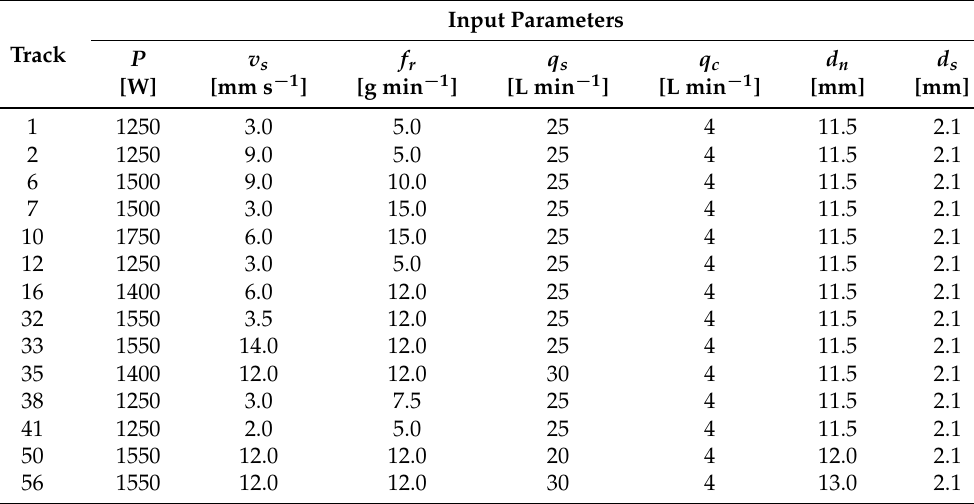
Table 2. The used parameters in the single track depositions pertaining to the parametrisation of 18Ni300 Maraging steel on H13